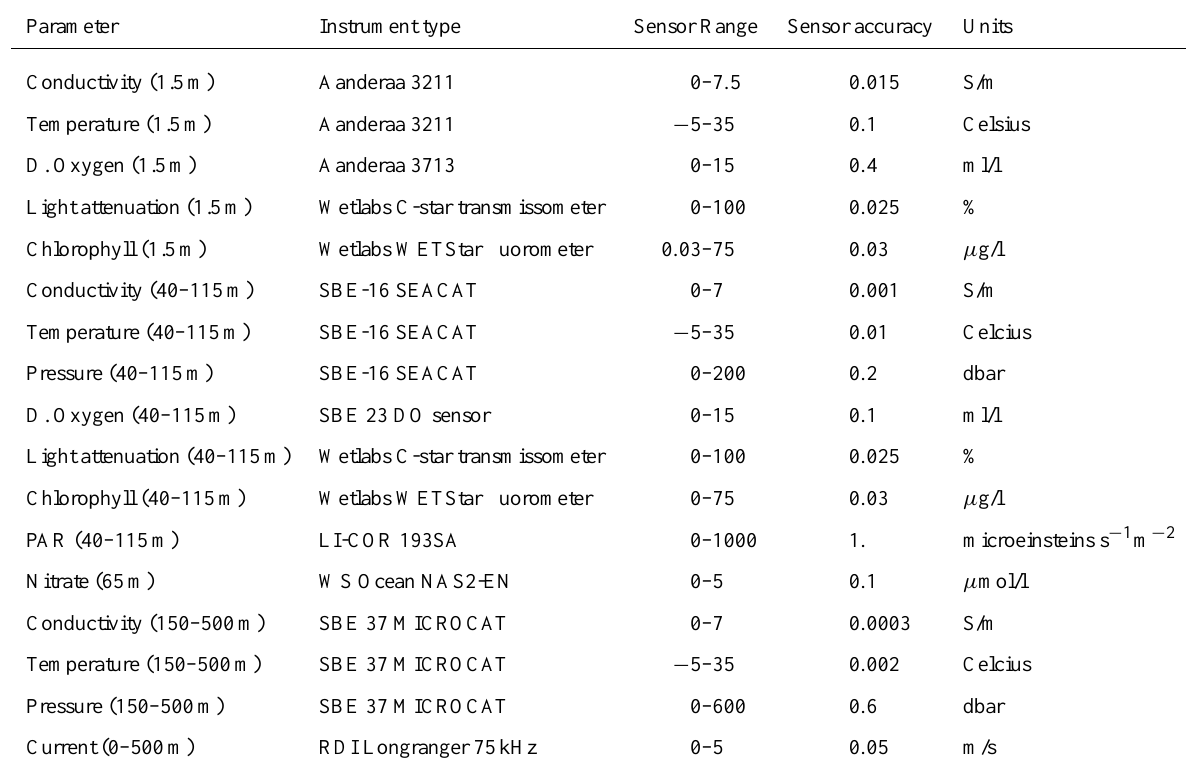
Table 2. Type and accuracy of sensors used for the oceanographic measurements of the M3A system Parameter Instrument